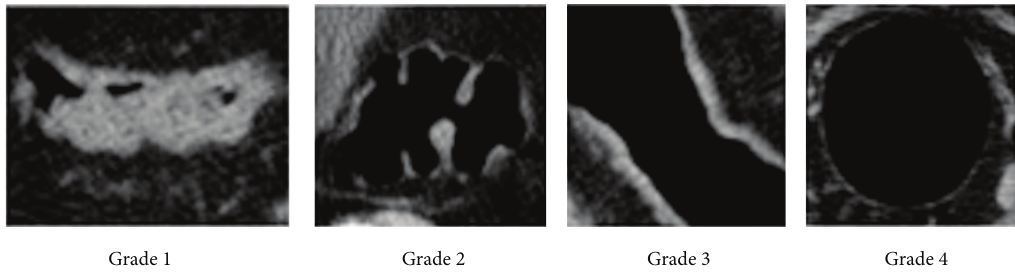
Figure 1: Selected images demonstrating the 4-point colonic distention grading scheme adapted from Burling et al. [5]. Grade 1 indicates complete collapse. Partial collapse (grade 2) was designated when the thickest portion of the haustral folds measured more than 4 mm in width or met within the lumen. Reasonable but suboptimal distention (grade 3) was defined as an easily visible slightly thickened colon wall, and optimal distention (grade 4) was designated when the colonic wall was thin and sharp.